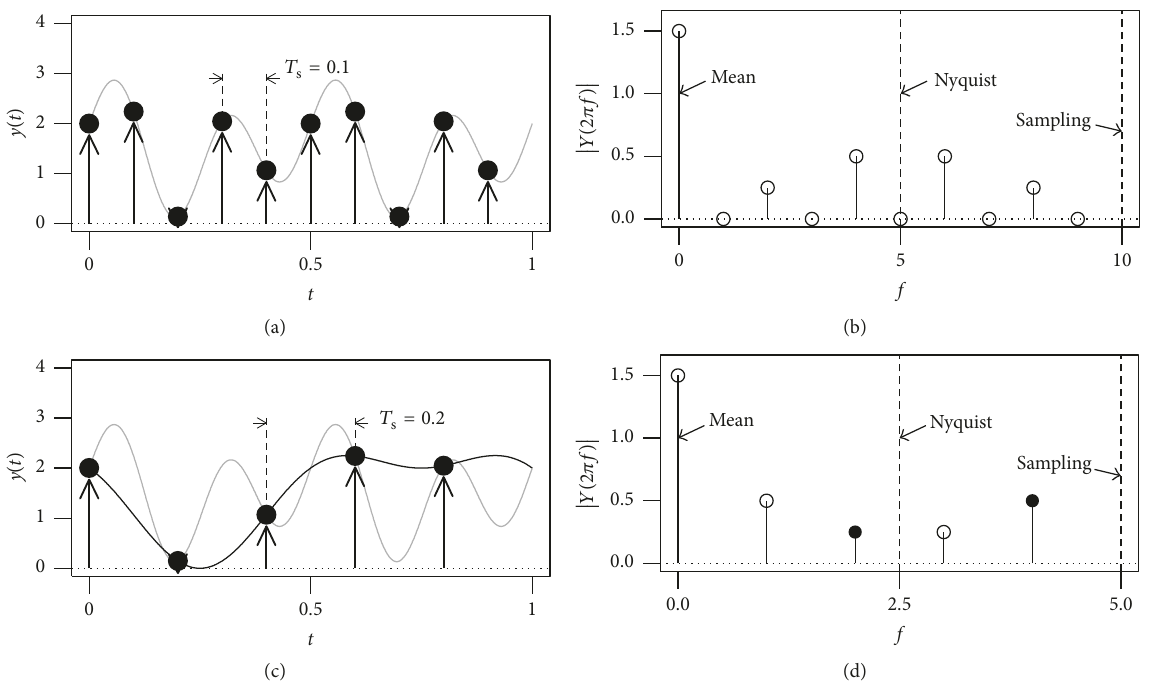
Figure 3: (a, b) The signal 𝑦(𝑡) is sampled marginally. In (c, d), it is undersampled so the upper and lower parts of the spectrum infiltrate each other. Compare the filled symbols, which correspond to the points in the lower half plane of (b). The black line in (c) indicates the alternative